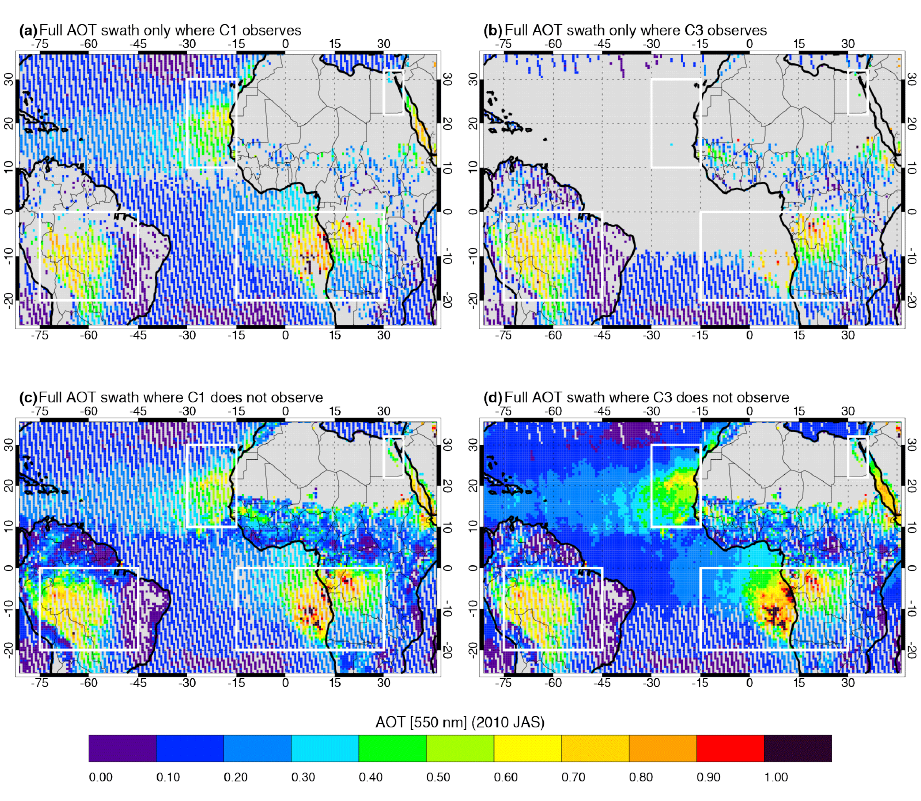
Figure 7. Full-swath seasonal (July-August-September 2010) MODIS Aqua AOT over the tropical Atlantic Ocean. The full-swath seasonal mean is masked to show only grid cells where the C1 and C3 sub-samples do (a, b) and do not (c, d) have a seasonal mean value. Figure 7a and b illustrate the “average-then-mask” seasonal mean AOT. The white boxes outline regions discussed in the text.